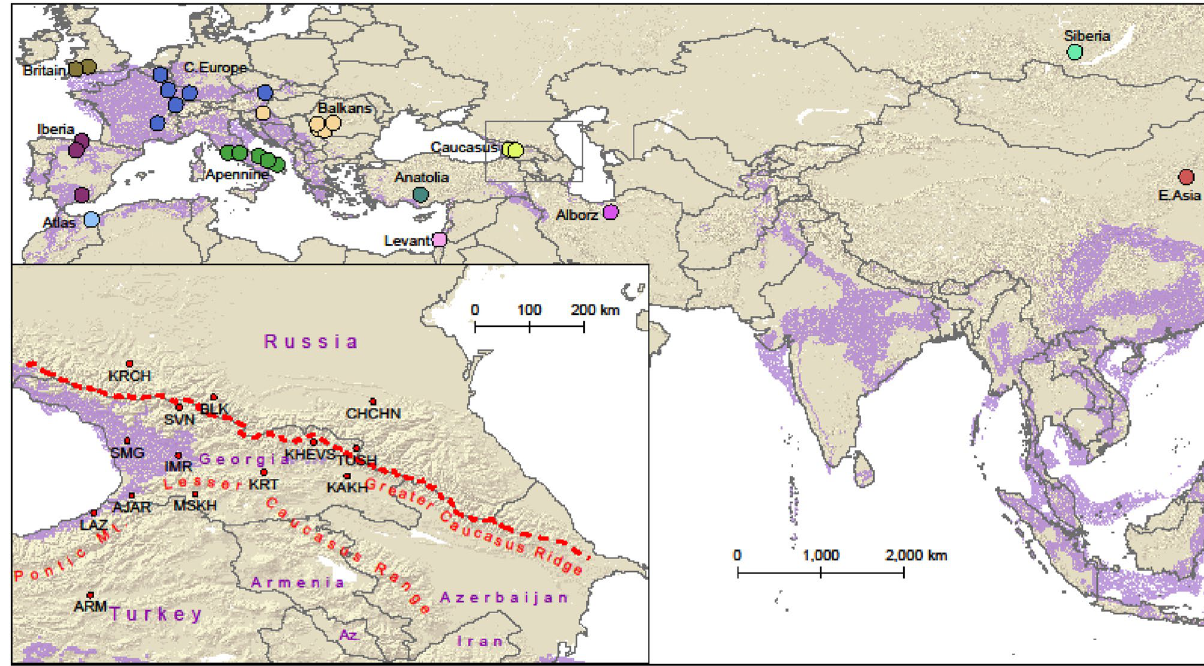
Figure 1. The distribution of the study populations: averaged centroids of ancient populations (uniquely colored points in the main map, see Table 2 for details) and hubs of the modern Caucasian populations (identified in the inset map, see Table 1 for details). Glacial human refugia extracted from Gavashelishvili and Tarkhnishvili 5 are shaded in purple. The map is generated using QGIS Desktop 3.10.6-A Coruña (https:// qgis.